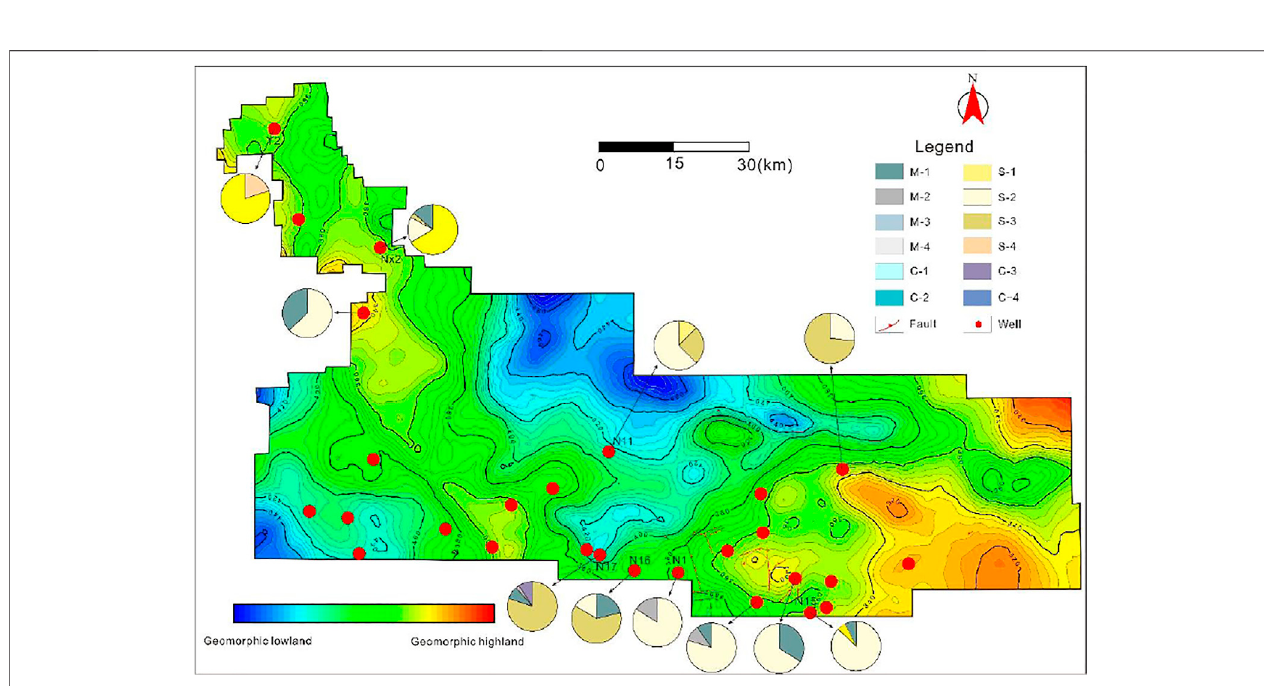
FIGURE 9 | Lithofacies proportions of the Long11-2 section in different geomorphic units in the Changning area.